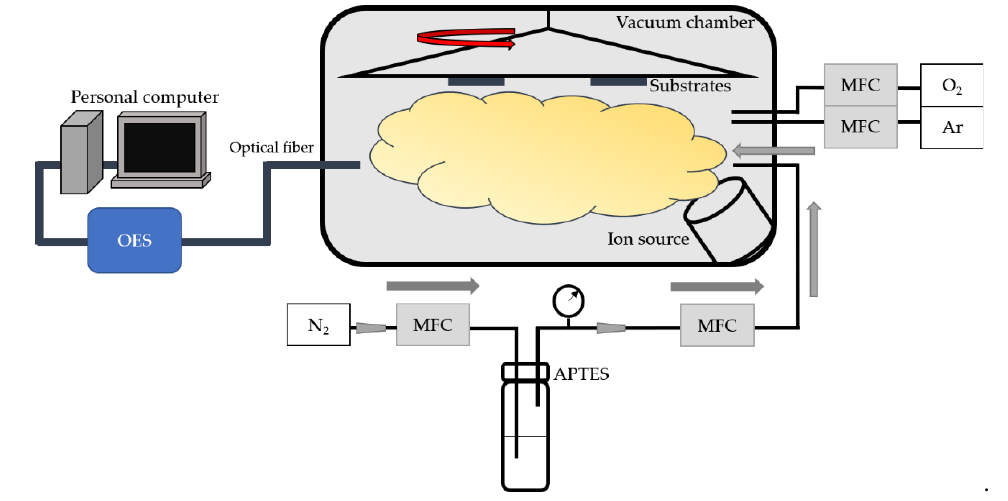
Figure 1. Ion source plasma bombarding and coating system.